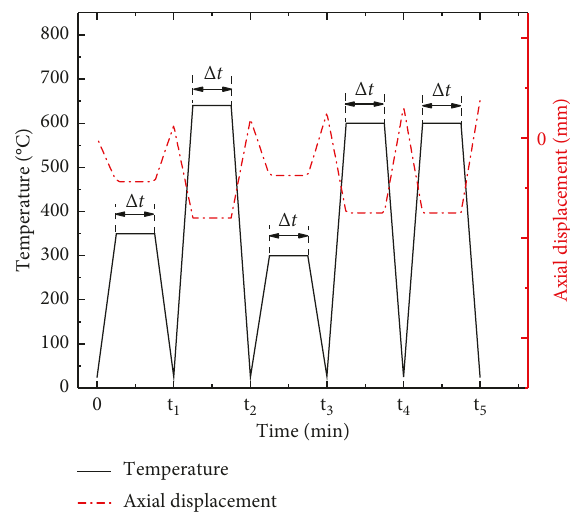
Figure 2: Experimental procedure. Note: